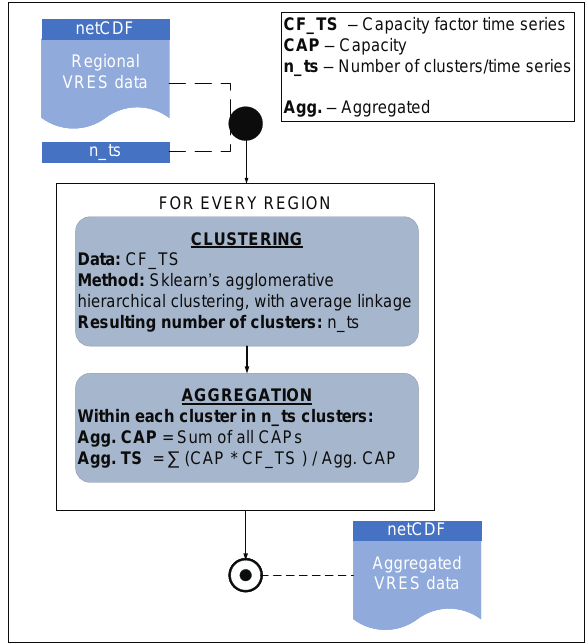
Figure 4. Flowchart of technological aggregation